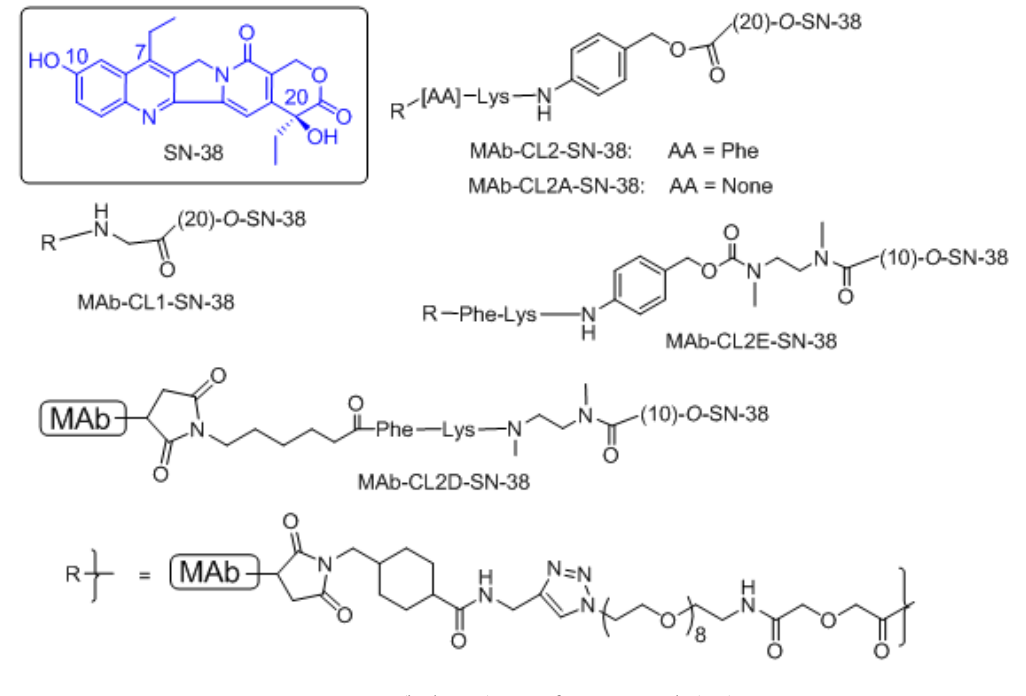
FIGURE 4. Antibody conjugates of some SN-38 derivatives.